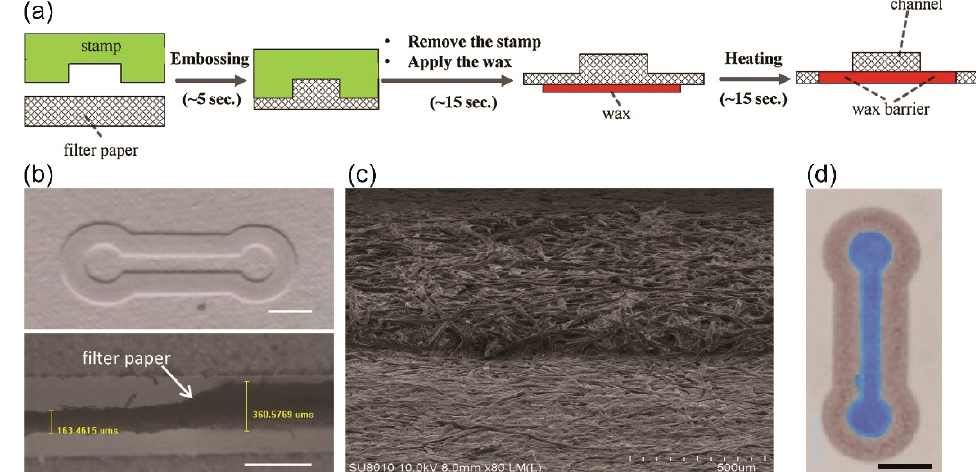
Figure 5. ( a ) Schematic of the fabrication process, including embossing, for the p-CMF device. ( b ) Images of the top (top) and cross-sectional (bottom) views of the embossed paper channel. ( c ) SEM image of the boundary of the embossed paper channel before applying wax. ( d ) p-CMF device after applying the wax and loading it with blue ink. Scale bars represent 5 mm. Reprinted with permission from the authors of [55]. Copyright 2018 Elsevier B.V.